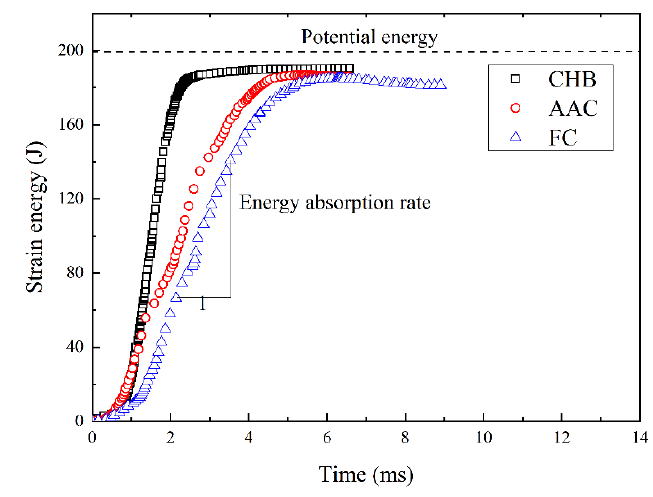
Figure 6. Evolution of strain energy with time during drop-weight tests.